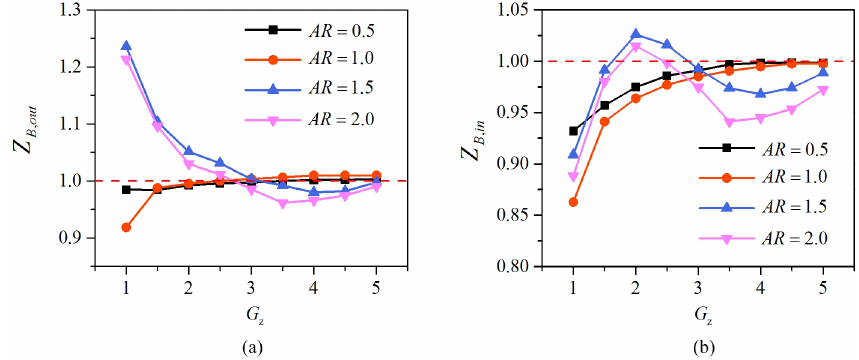
Figure 8. The relative flapping amplitude versus transverse distance: ( a ) outer side; ( b ) inner